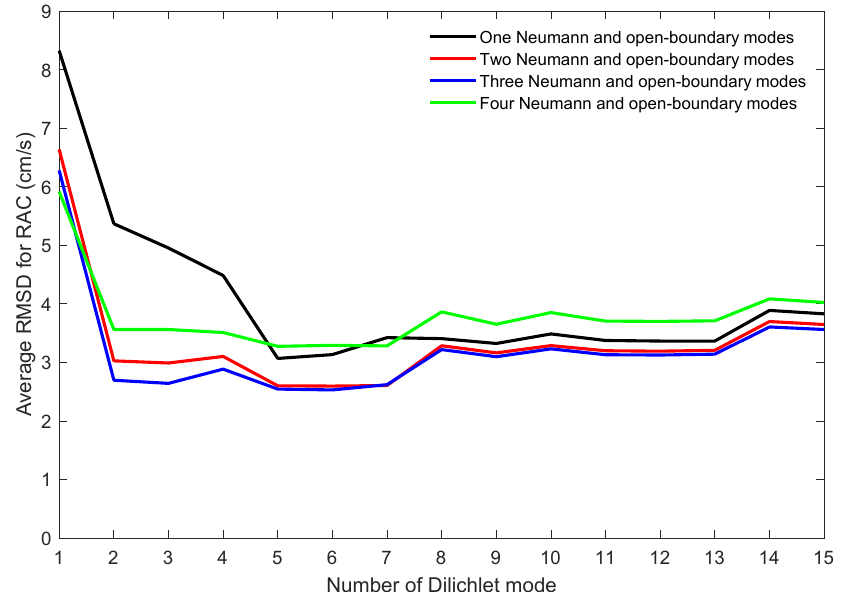
Figure 5. Five-path averaged RMSDs for RAC, plotted against the number of Dirichlet modes. The number of Neumann modes and open-boundary modes changes from 1–4, corresponding to the black, red, blue, and green lines, respectively.